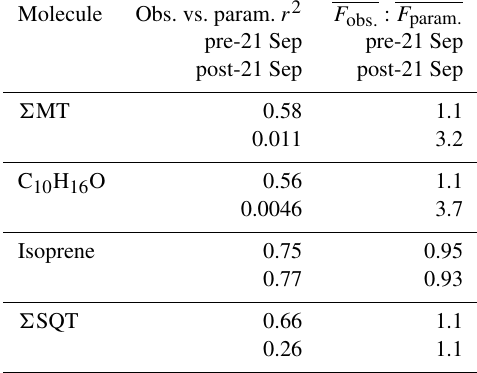
Table 2. Summary of correlation coefficients ( r 2 ) from Fig. 9e– h. All fits are through the origin. Included is the ratio of the av- erages of observed and parameterized fluxes during the pre- and post-21 September periods.